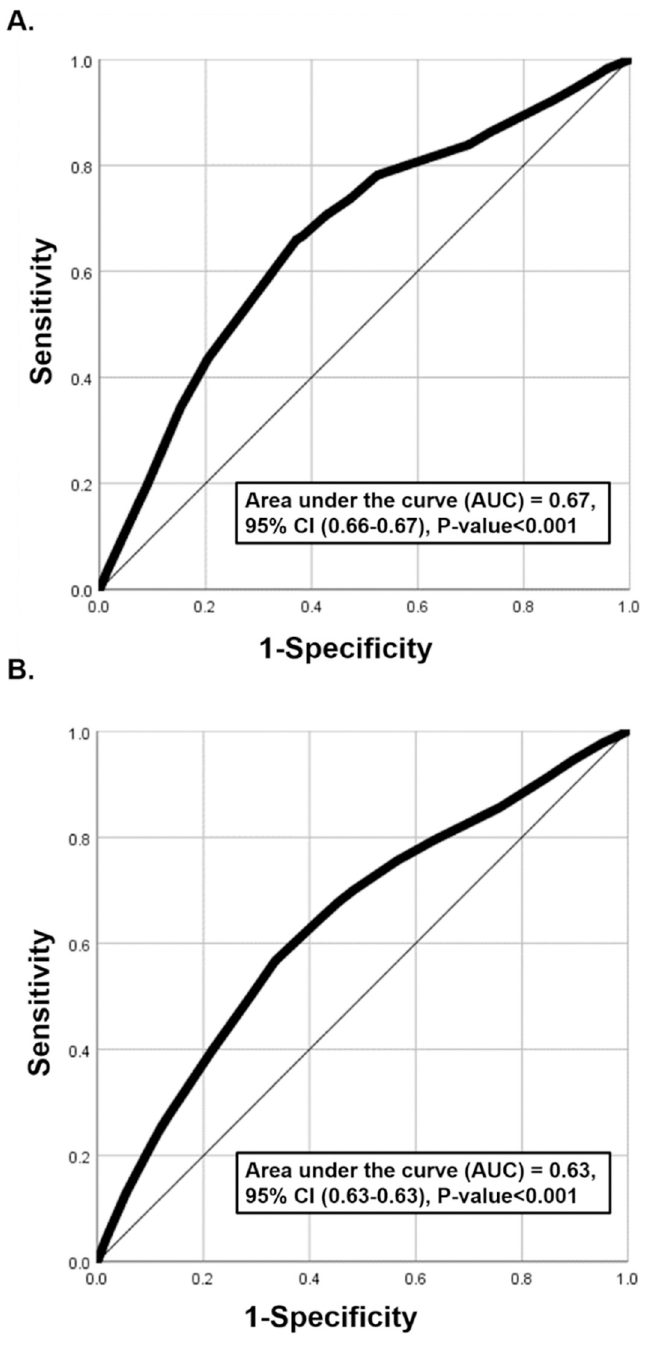
Fig 1. Diagnostic performance of the A) original and B) updated Qatar COVID-19 risk scores, assessed using the area under the receiver operating characteristic (ROC) curve.